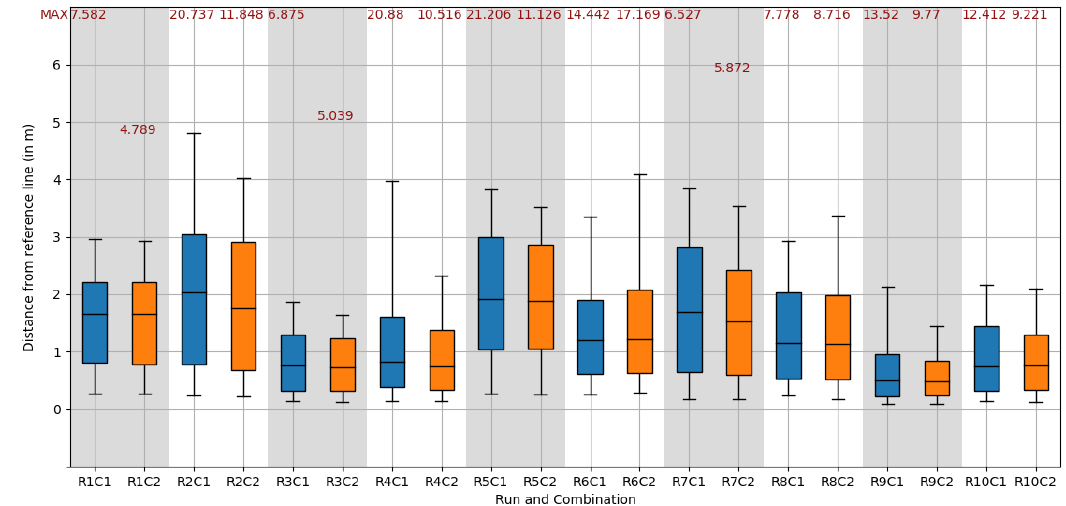
Figure 5. Boxplots of perpendicular distance of the mapped track from combinations 1 (blue) and 2 (orange) to the reference track. The numbers in red are the maximum distances from the reference line.